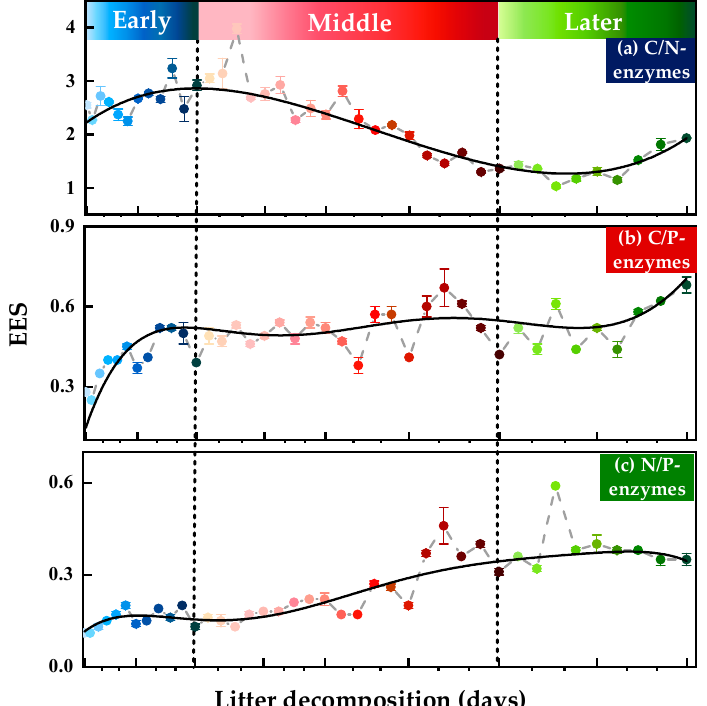
Figure 2. The variations of soil extracellular enzymatic stoichiometry (EES) during the plant residue transformation. ( a ) C/N-enzymes; ( b ) C/P-enzymes; ( c ) N/P-enzymes. All ratios are expressed as the mean ± SE. The dashed lines in the graph represent the actual variation rules. The solid lines are the fitted curves. C/N-enzymes: R 2 = 0.94 ***; C/P-enzymes: R 2 = 0.46 **; N/P-enzymes: R 2 = 0.86 ***. ** p < 0.01, and *** p < 0.001.